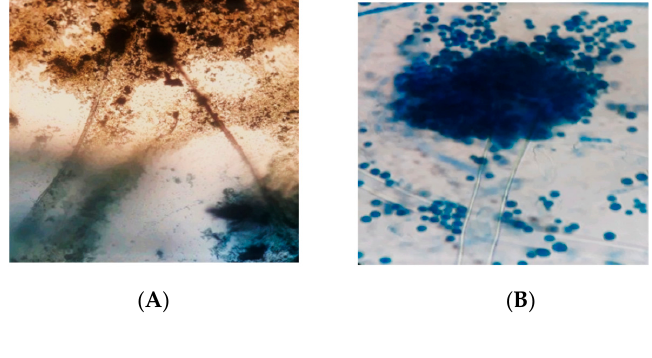
Figure 4. Colony morphology of A. flavus on Aspergillus flavus and Aspergillus parasiticus agar (AFPA); ( A ) = obverse, ( B ) = reverse.